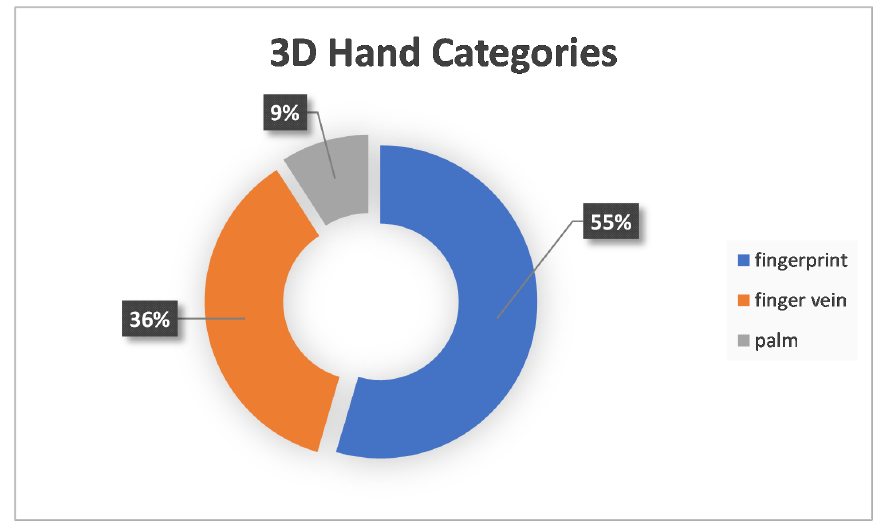
Figure 5. Three-Dimensional (3D) Hand Categories.